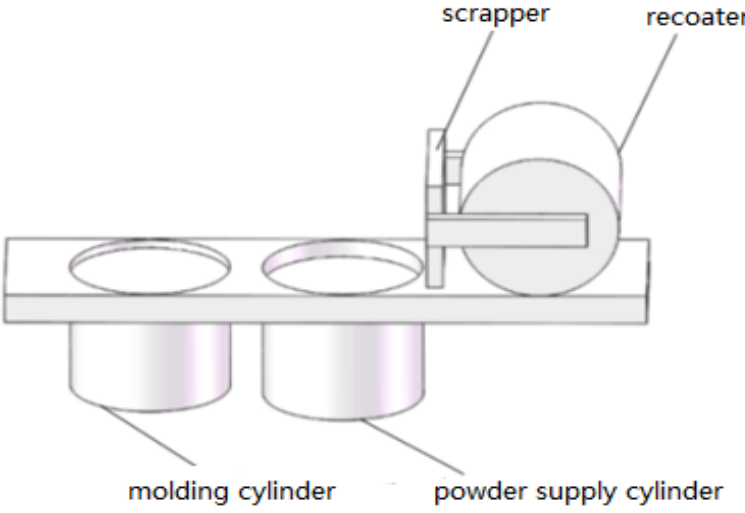
Figure 5. Model of the powder laying device.